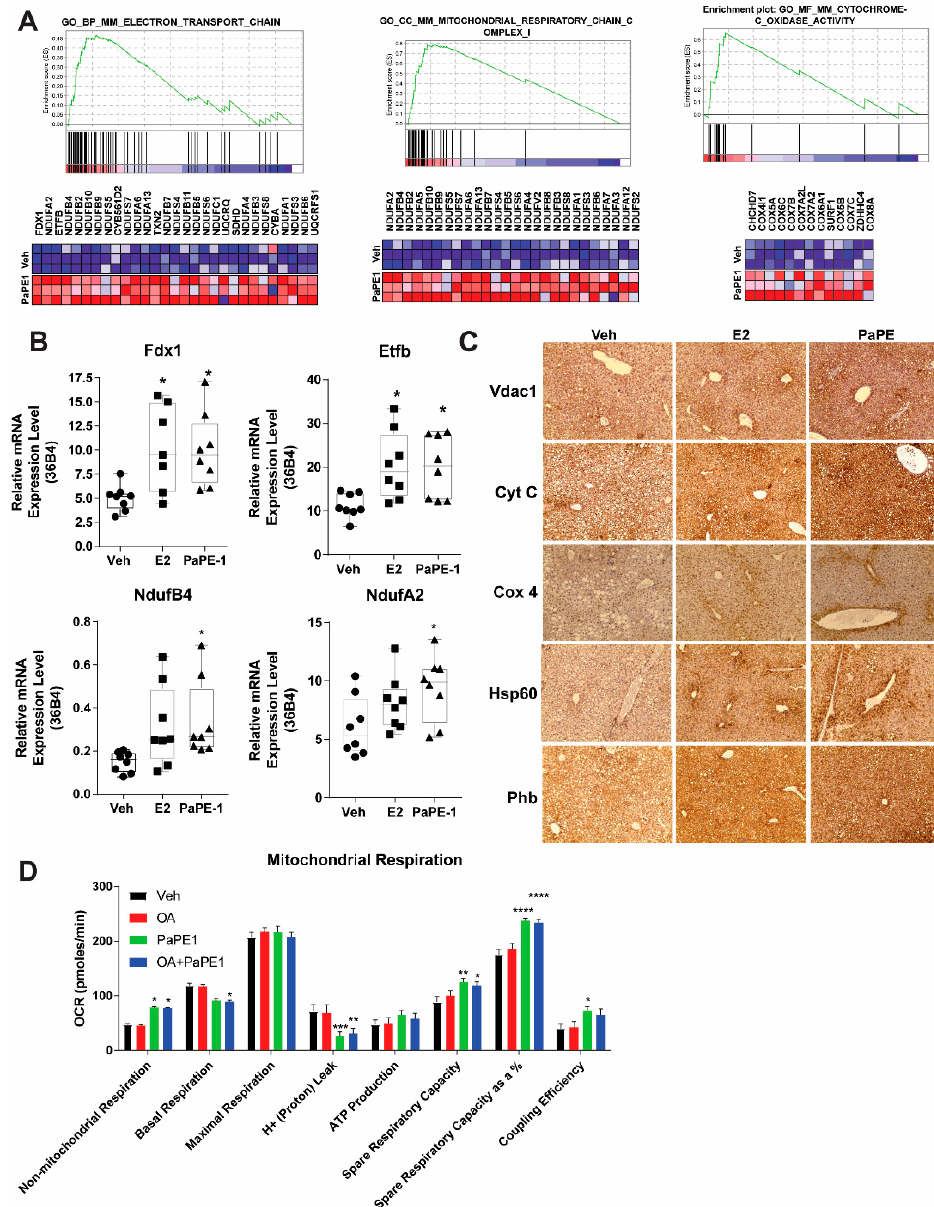
Figure 4. Increased mitochondrial gene and protein expression in PaPE-1 treated livers. ( A ) Exam- ples of GSEA metabolic pathways. Electron transport chain, Mitochondrial respiratory chain, and cytochrome oxidase activity were three of the highly enriched gene sets in GSEA analysis. Range of colors (red, pink, light blue, dark blue) corresponds to a range of expression values (high, moderate, low, lowest). ( B ) PaPE-1 mediated the upregulation of the genes in these gene sets. ( C ) Consistent with our GSEA results, PaPE1 treated livers had an overall higher expression of mitochondrial pro- teins. ( D ) HepG2-ER α cells were treated in triplicate using Veh, 1 µ M PaPE-1, 100 nM OA, and 1 µ M PaPE-1 + 100 nM OA. Different oxidative respiration parameters were calculated using a Seahorse Mitostress test kit. *, p < 0.05; **, p < 0.01; ***, p < 0.001; ****, p <